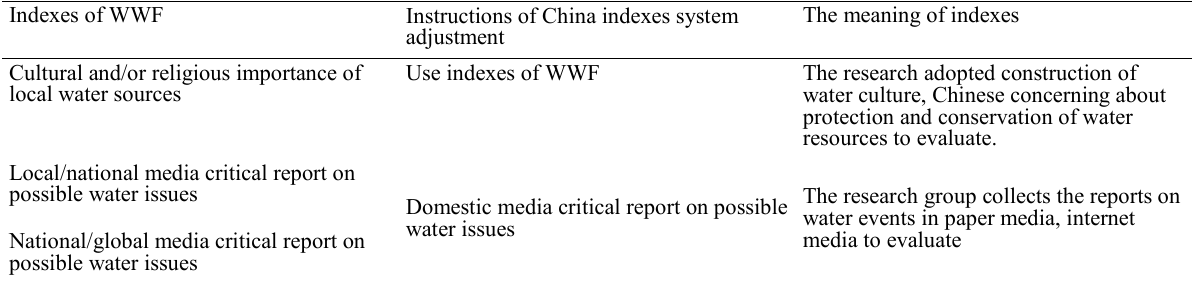
Table 3 Reputational risk assessment